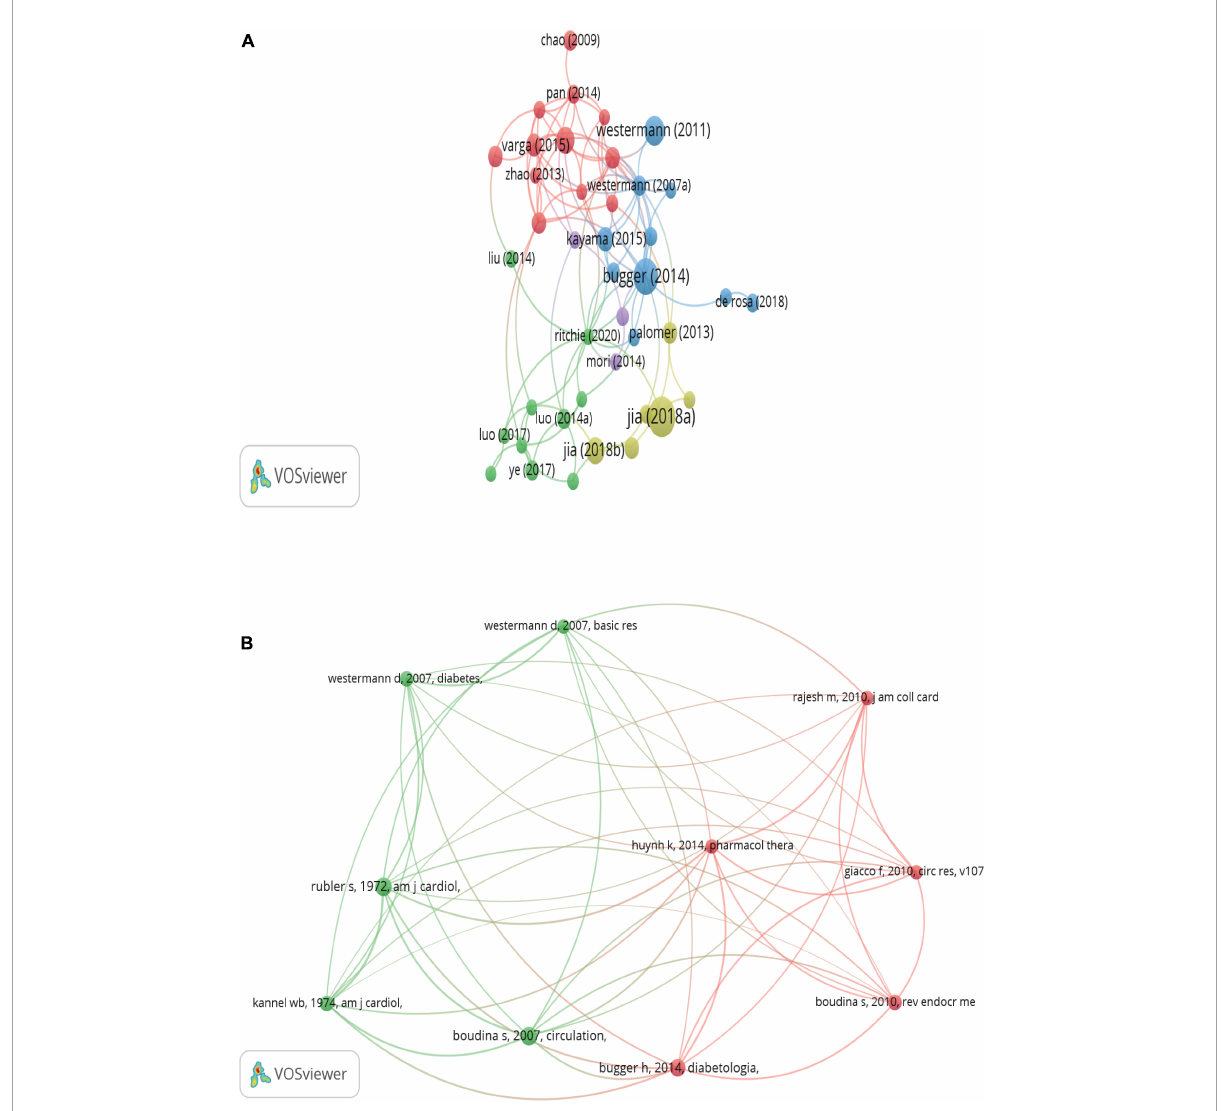
FIGURE6 Network map of citation analysis of publications. (A) Mapping of citation analysis of documents. (B) Network map of co-citation analysis of references. The analysis method was Linlog/modularity in VOSviewer, the weight was an occurrence, and scores were the average published